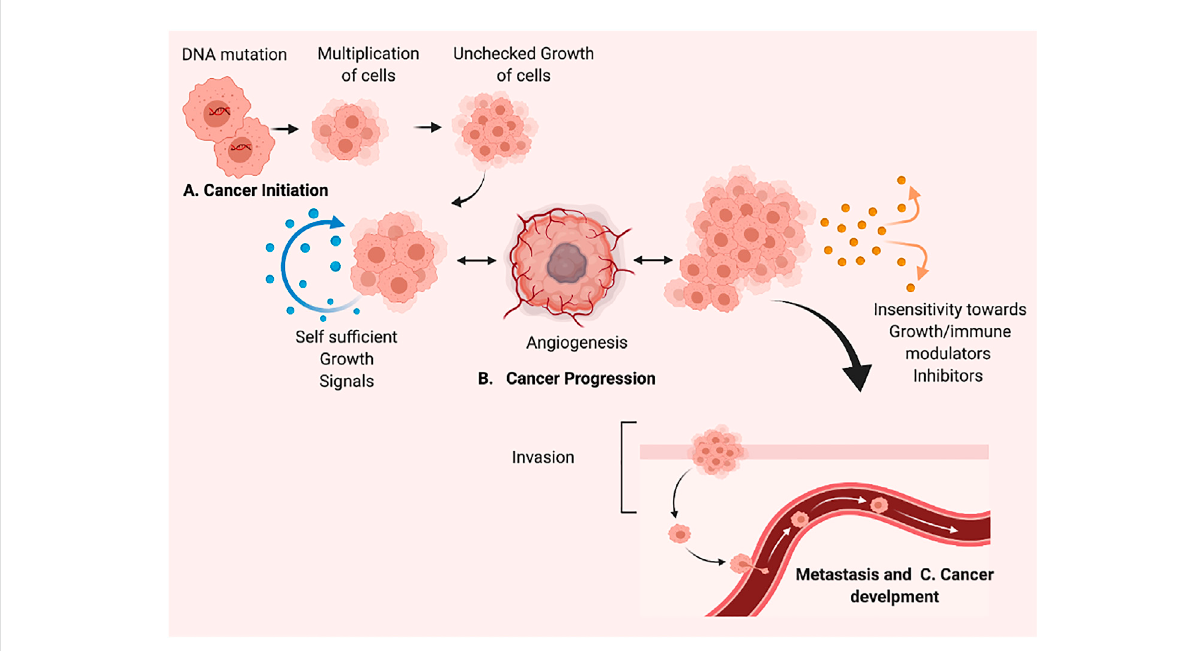
FIGURE 1 The process of cancer development/carcinogenesis, (A) Cancer initiation (B) . Cancer Progression (C) . Metastasis and Cancer development. Created with